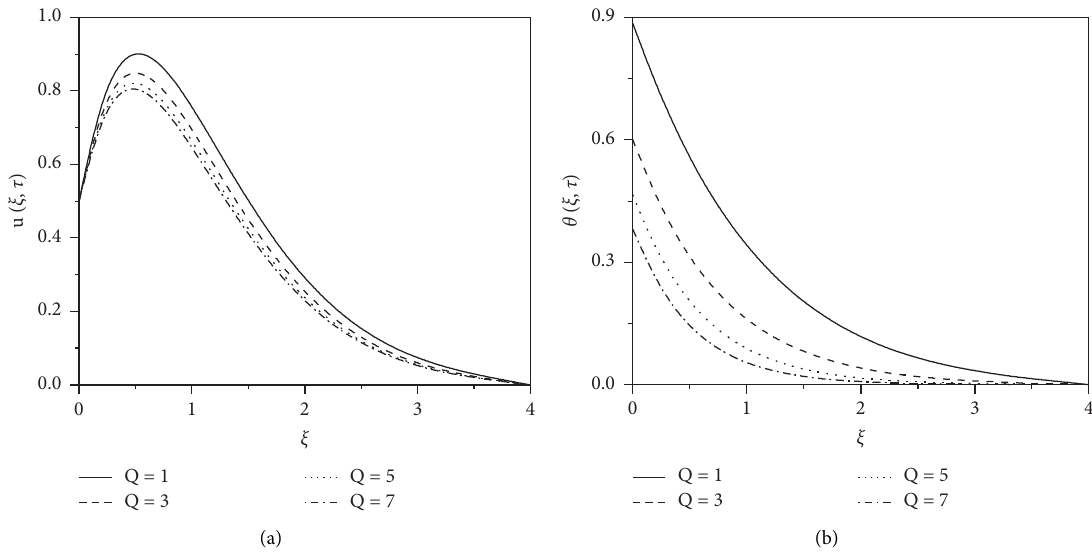
Figure 3: Variation of (a) velocity u ( ξ , τ ) and (b) temperature θ ( ξ , τ ) against ξ for various values of Q